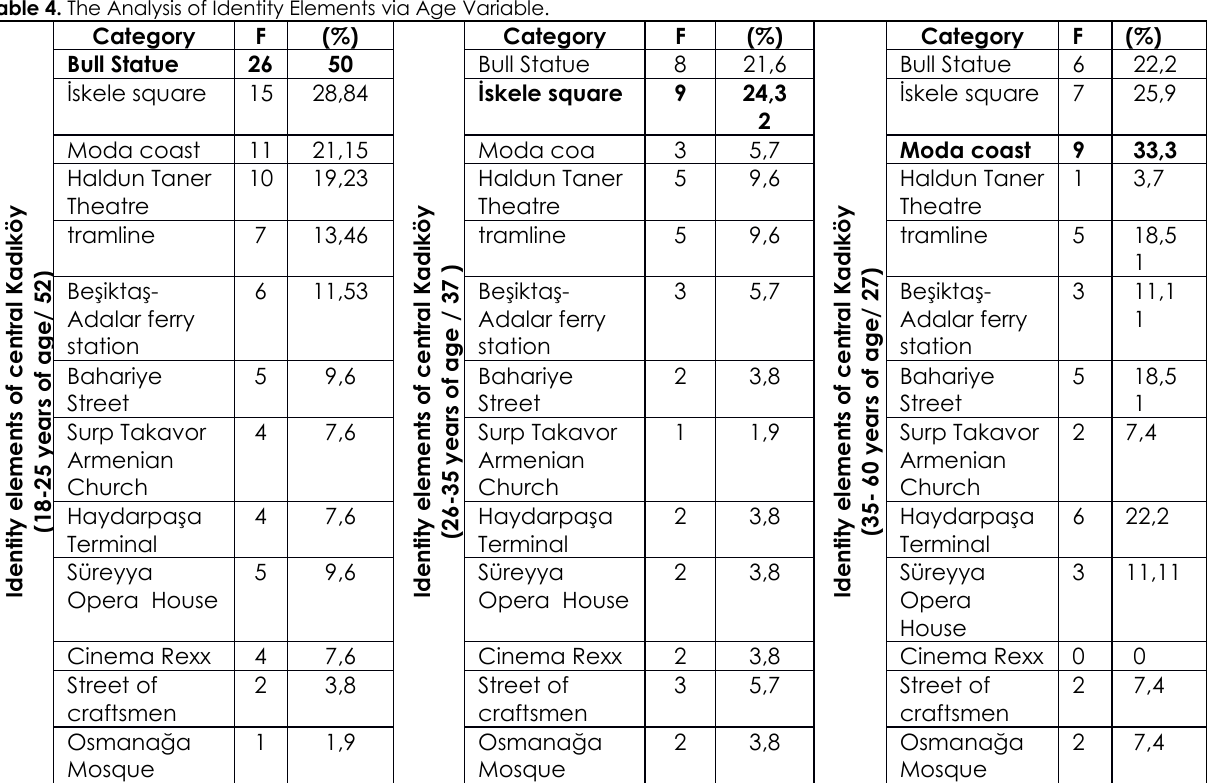
Table 4. The Analysis of Identity Elements via Age Variable.